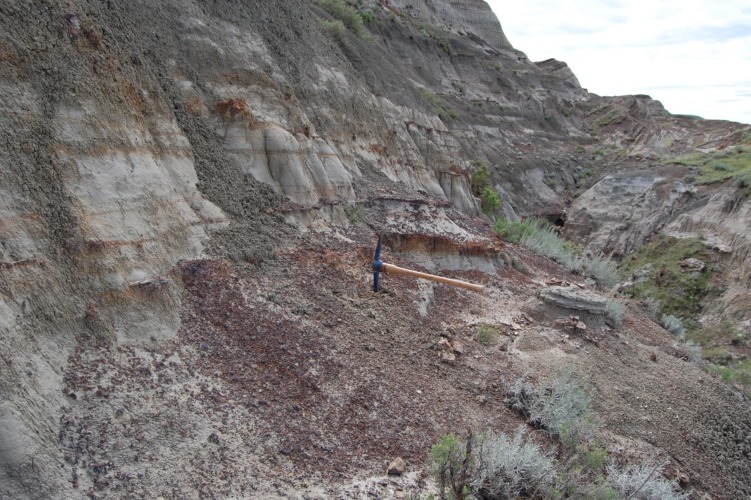
Region of BB180 sampled prior to removal of overburden.